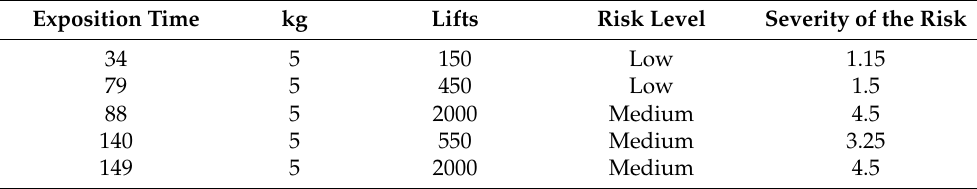
Table 10. Severity of the risk for 5 kg mass for different exposition times and